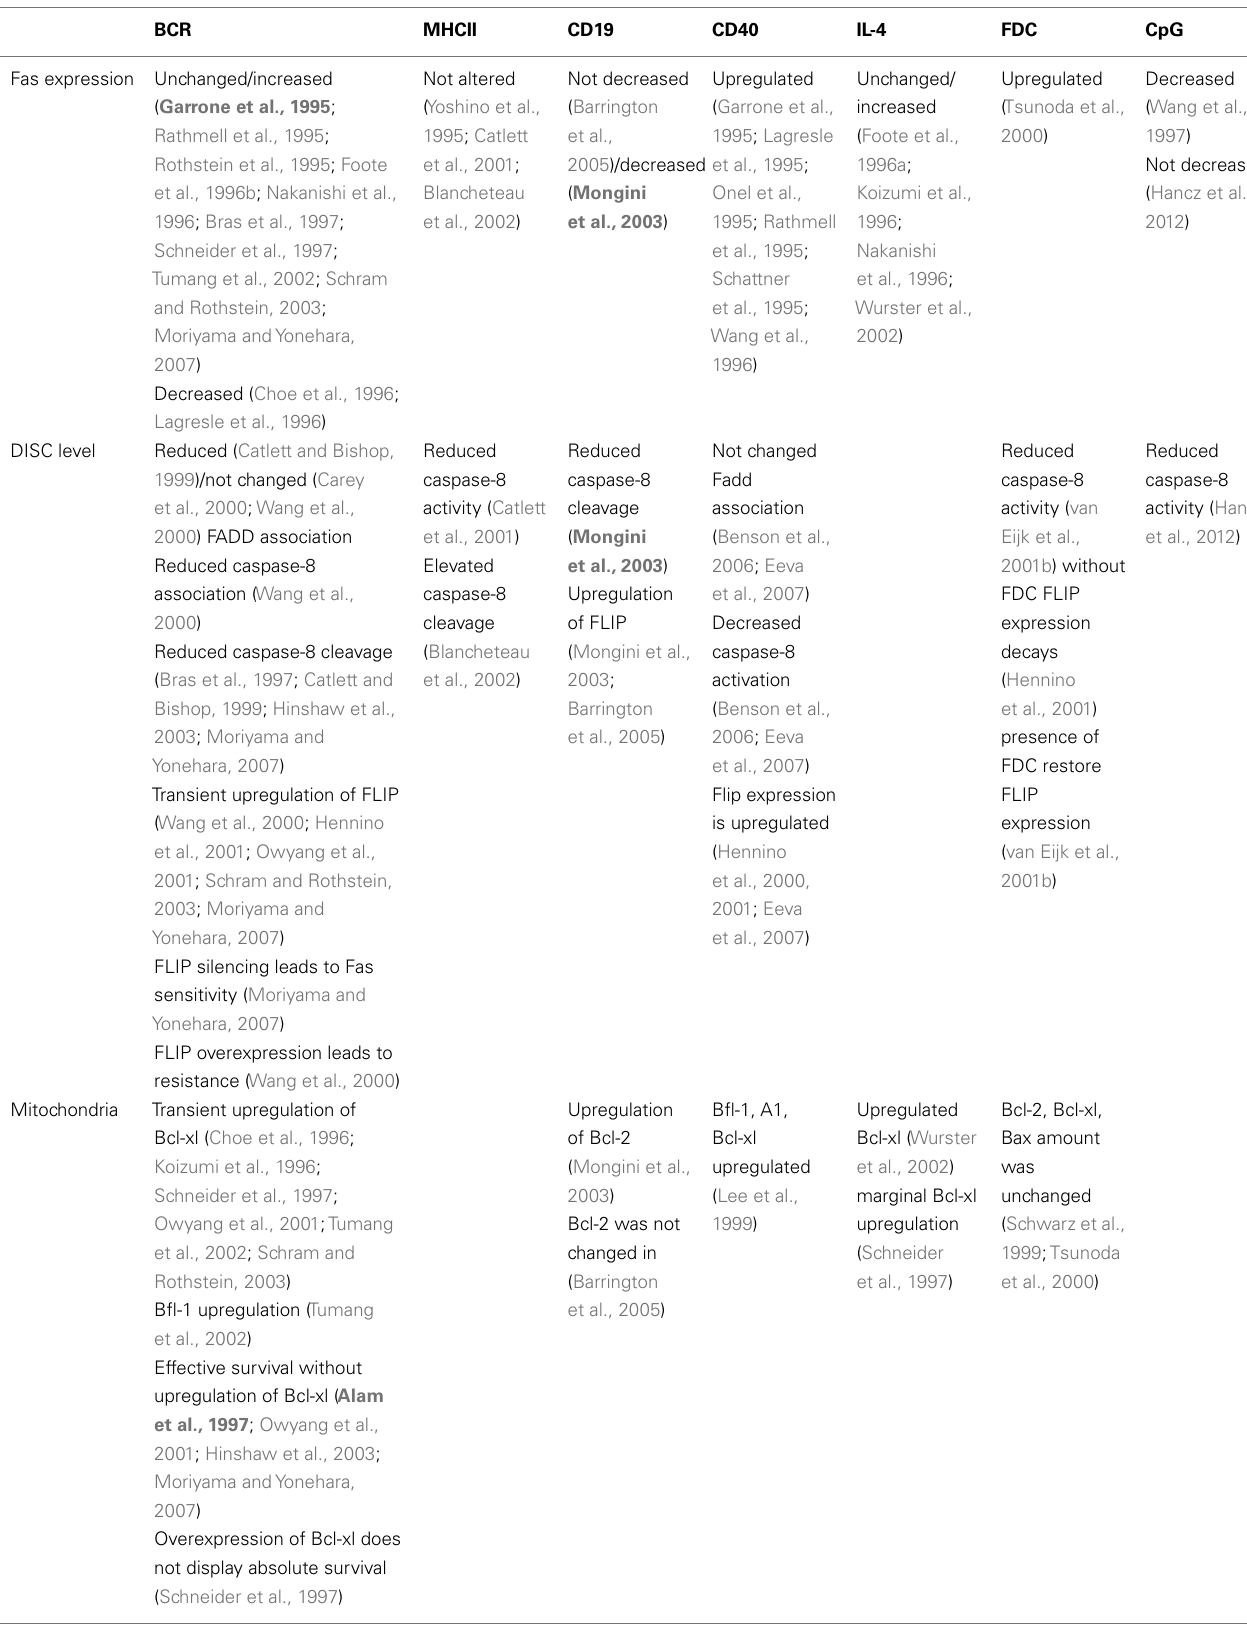
Table 2 | Detailed molecular mechanism of inhibition of Fas-induced cell killing.